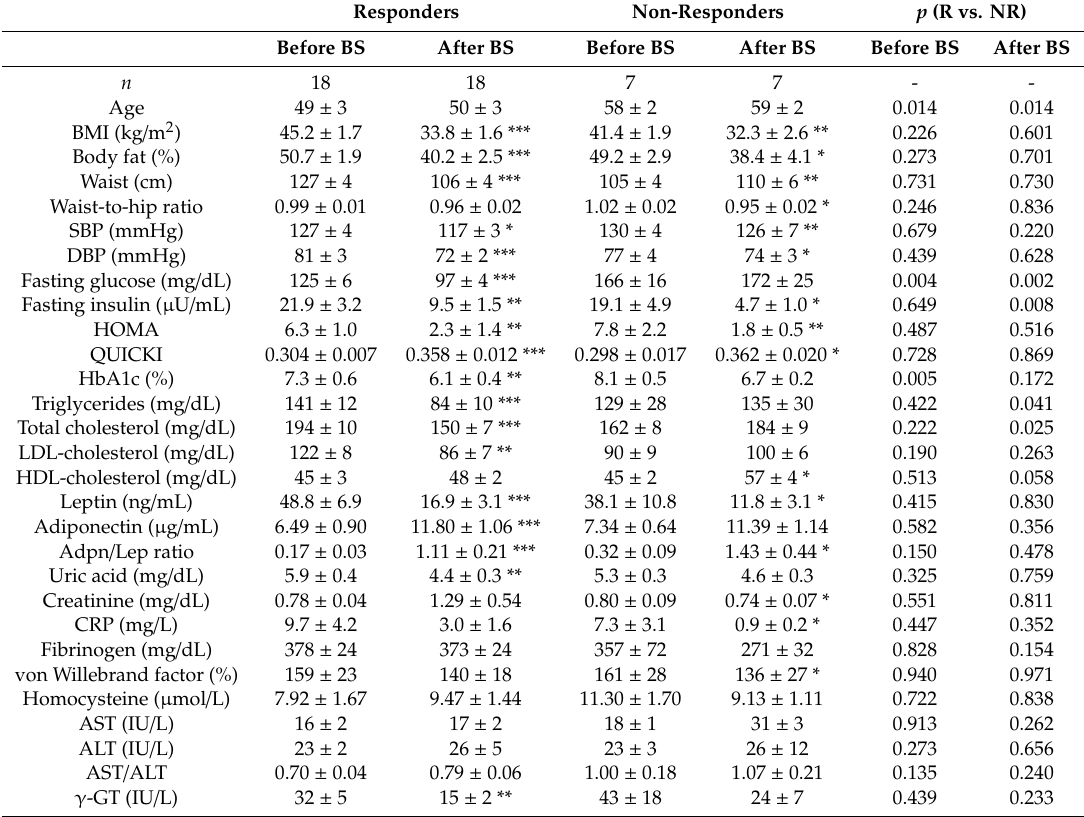
Table 4. E ff ects of weight loss one year after Roux-en-Y gastric bypass (RYGB) in obese patients with T2D classified as responders and non-responders.